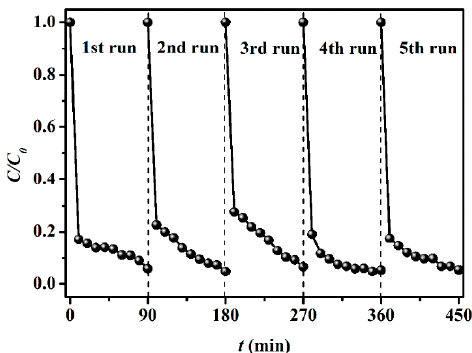
Figure 8. The recycle tests of HNTs as adsorbent for CIP removal.